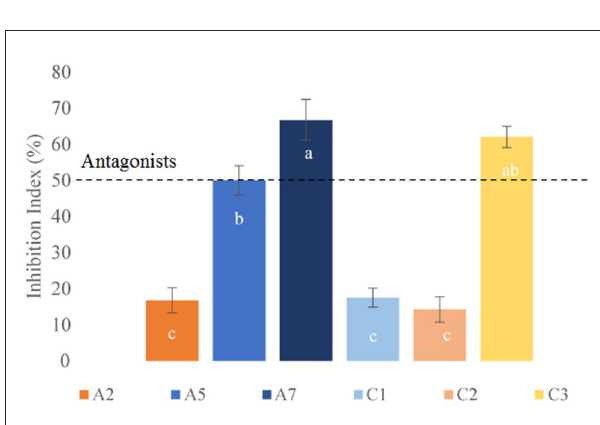
FIGURE4 Inhibition Index (I%) derived from the application of three actinobacteria selected and two-member consortia (Consortium 1-C1: A2 + A5; Consortium 2-C2: A2 + A7; and Consortium 3-C3: A5 + A7) against Botrytis cinerea (BC) in vitro . Bars indicate standard error. The letters inside the bars indicate different homogeneous groups with statistically significant differences (Fisher’s LSD test, P <